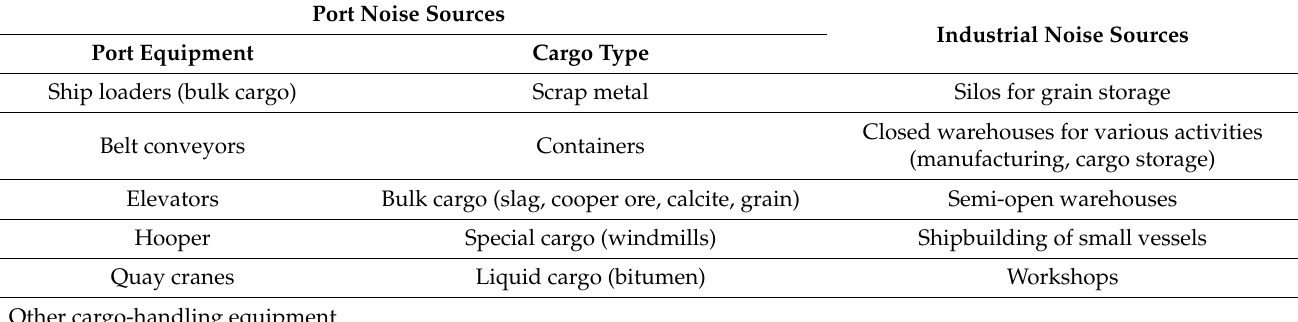
Table 7. Port and industrial noise sources in the port of